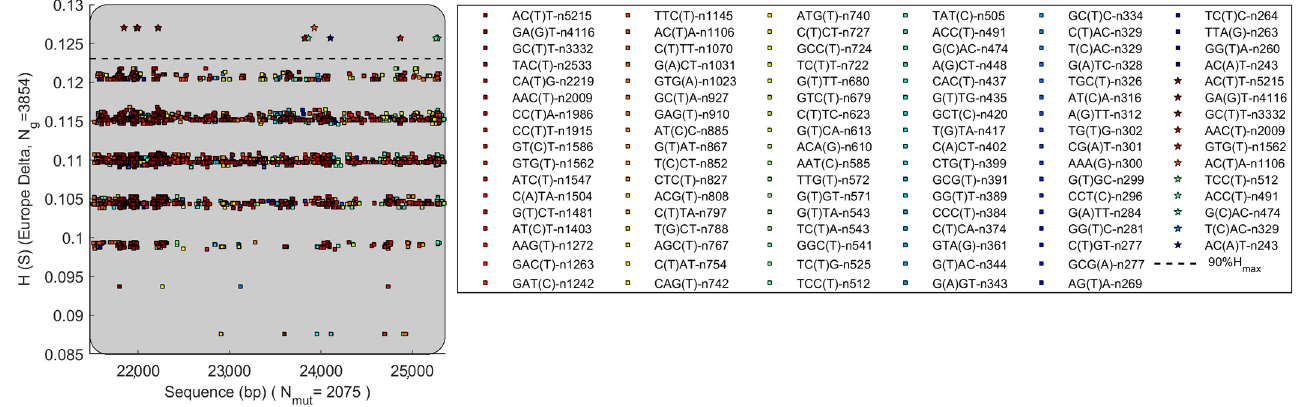
Figure 7. The ORF8 gene of Delta variant has mutated with different HGS. The dataset contains 3854 genomes with geolocation of Europe.